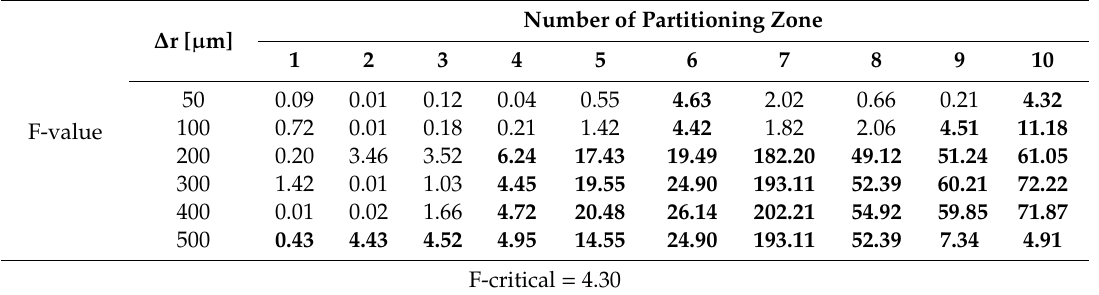
Table 1. The results of ANOVA (numbers in bold represent statistically significant differences caused by the beam misalignment). ∆ r [ µ